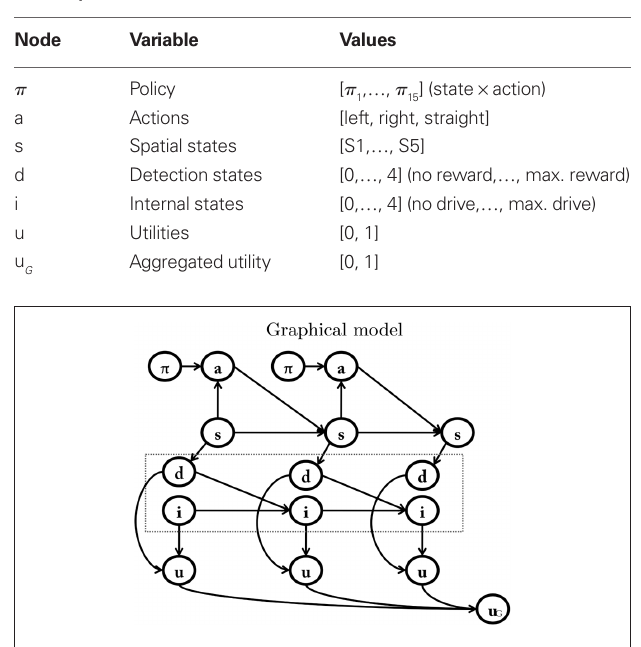
Table 2 | List of variables used in Figure